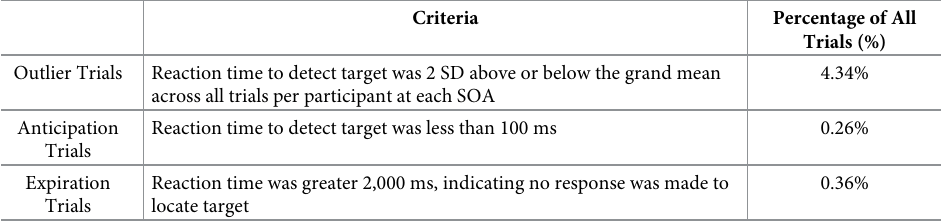
Table 2. Data cleaning analysis for European